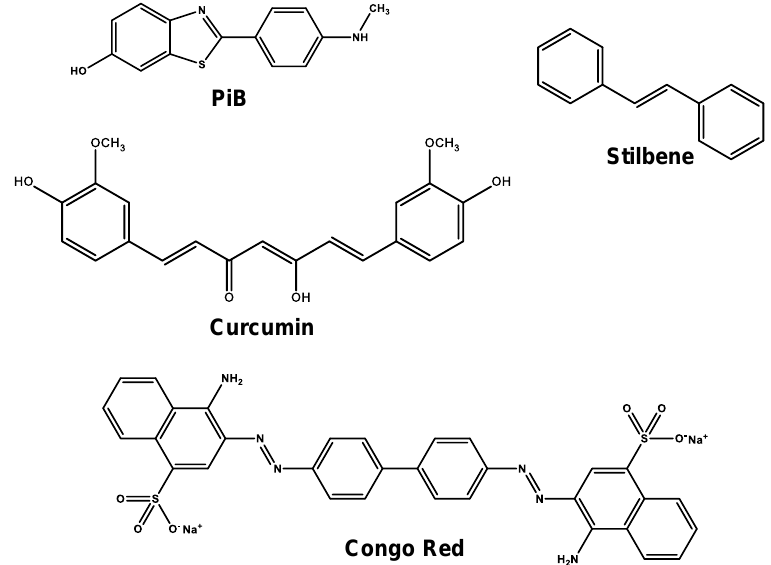
Scheme 6. Structures of small molecule derivatives for A β targeting: Pittsburgh compound B (PiB), curcumin, stilbene and Congo